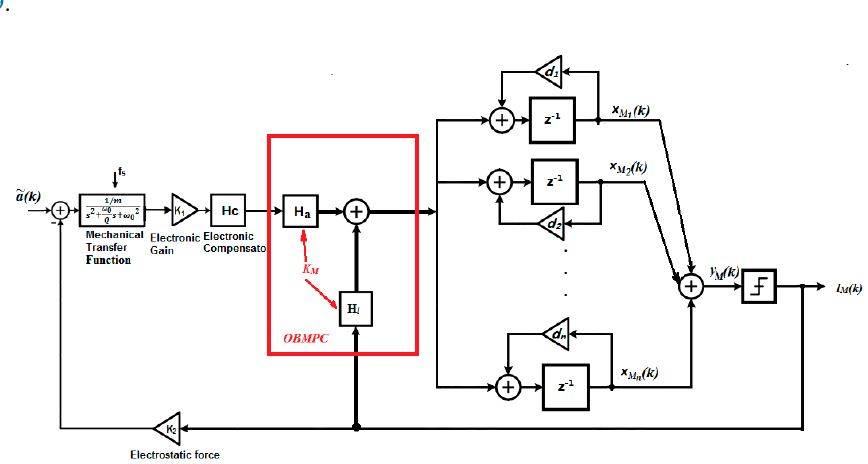
Figure 9. Design of a high order1-bit MEMS gyroscopeusing the OBMPC.